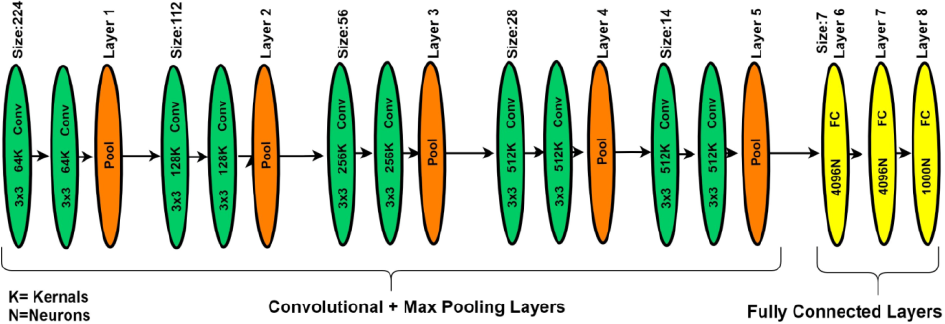
Figure 6. The VGG ‐ 19 model for patch ‐ based analysis of microaneurysms. Figure 6. The VGG-19 model for patch-based analysis of microaneurysms.